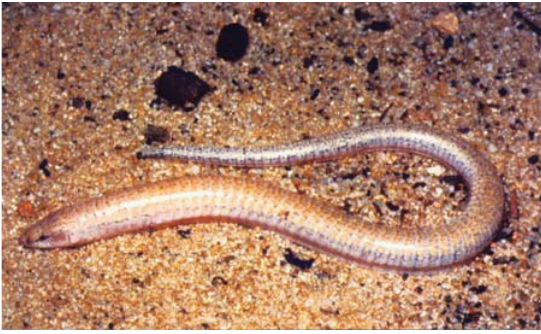
Figure 1 - Calyptommatus leiolepis , Bahia,